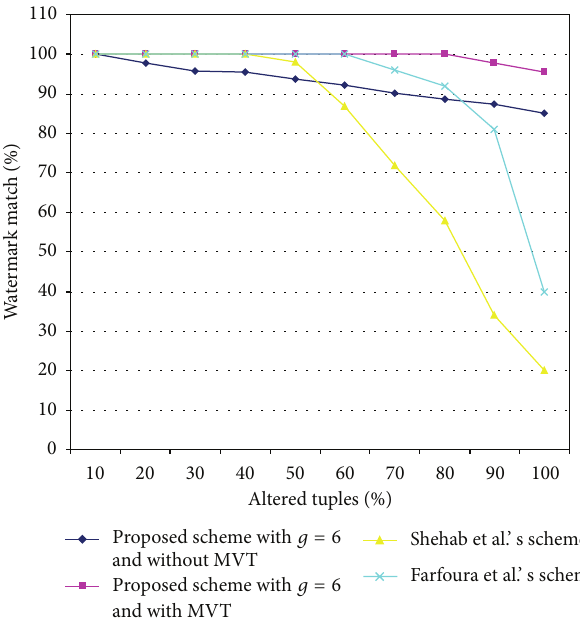
Figure 7: Comparison of the results for resilience to an alteration attack by the two proposed schemes and two other